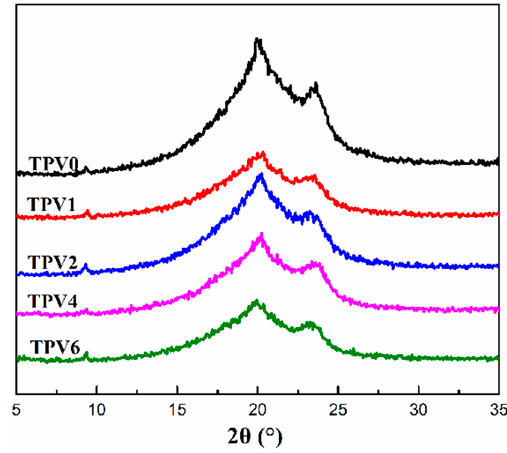
Figure 9. Wide-angle X-ray diffraction curves of TPV series.